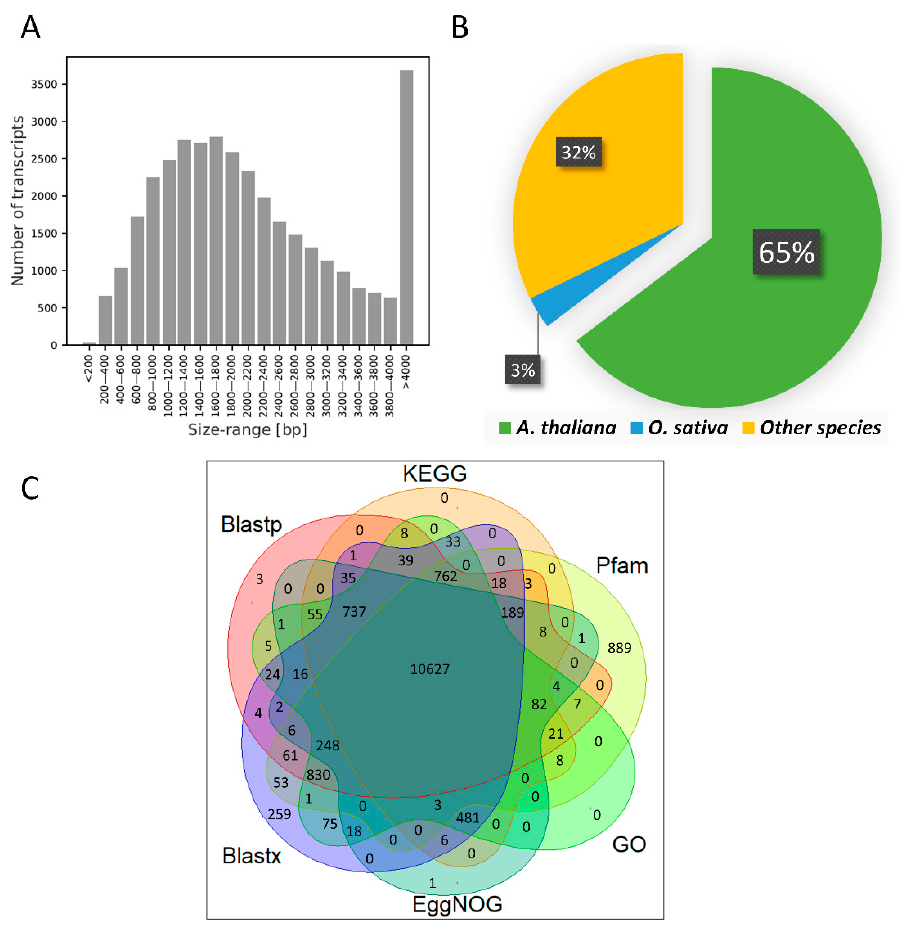
Figure 5. ( A ) Transcript size distribution. ( B ) Homologous species distribution. ( C ) Venn diagram displaying differences of annotation based on the Blastp, Blastx, KEGG, GO, EggNOG, and Pfam databases.